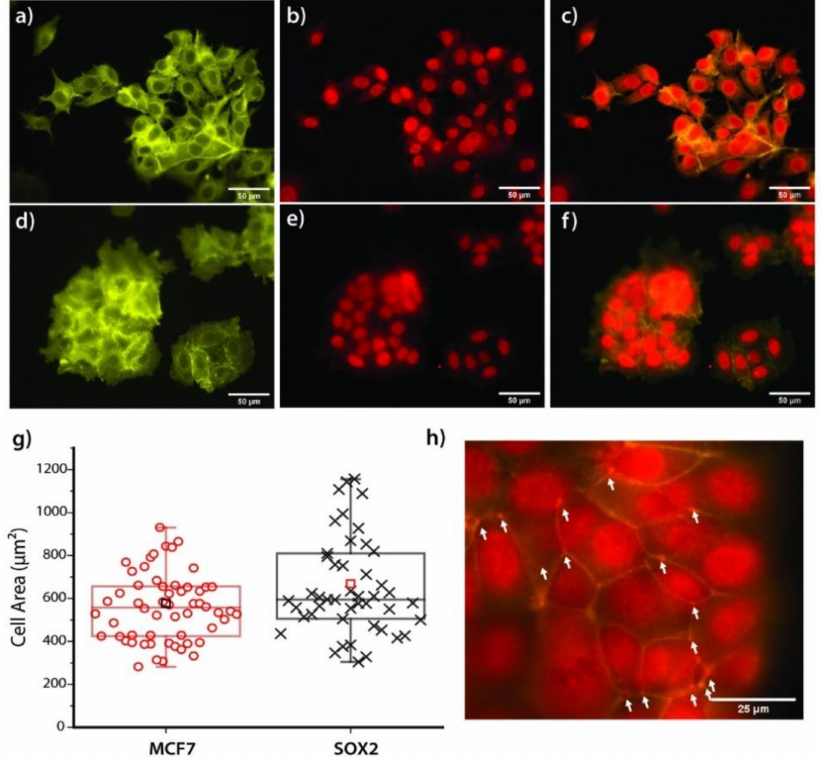
Figure 6. ( a – f ) Epifluorescence images of both MCF7 ( a – c ) and Sox2 ( d – f ) cell lines on top of Fibronectin (20 µ g / mL) film upon actin (in green) and vinculin (in red) staining. The scale bars correspond to 50 µ m. ( g ) Boxplot showing the distribution of the cell area values. N = 50. The square ( (cid:3) ) shows the mean value, the horizontal line represents the median, and the values range from the 5th to the 95th quantile. ( h ) Magnification over the cell–cell connection in Sox2 cells, showing the localized agglomeration of vinculin along the contact